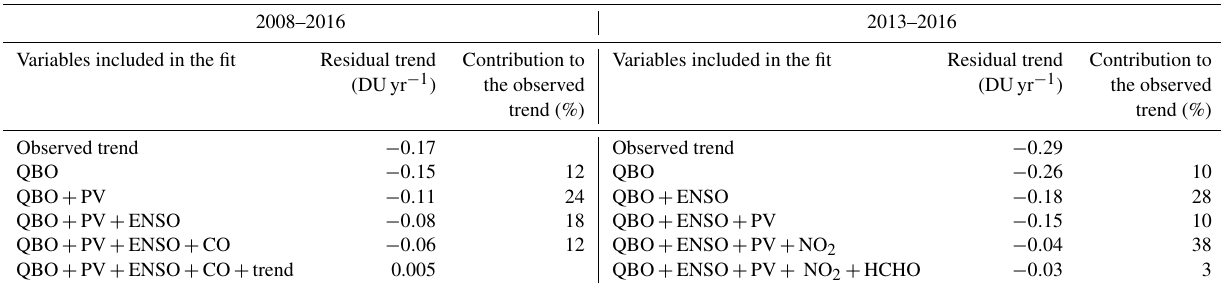
Table 2. Evolution of the residual trend, and the contribution of the explicative variables to the observed